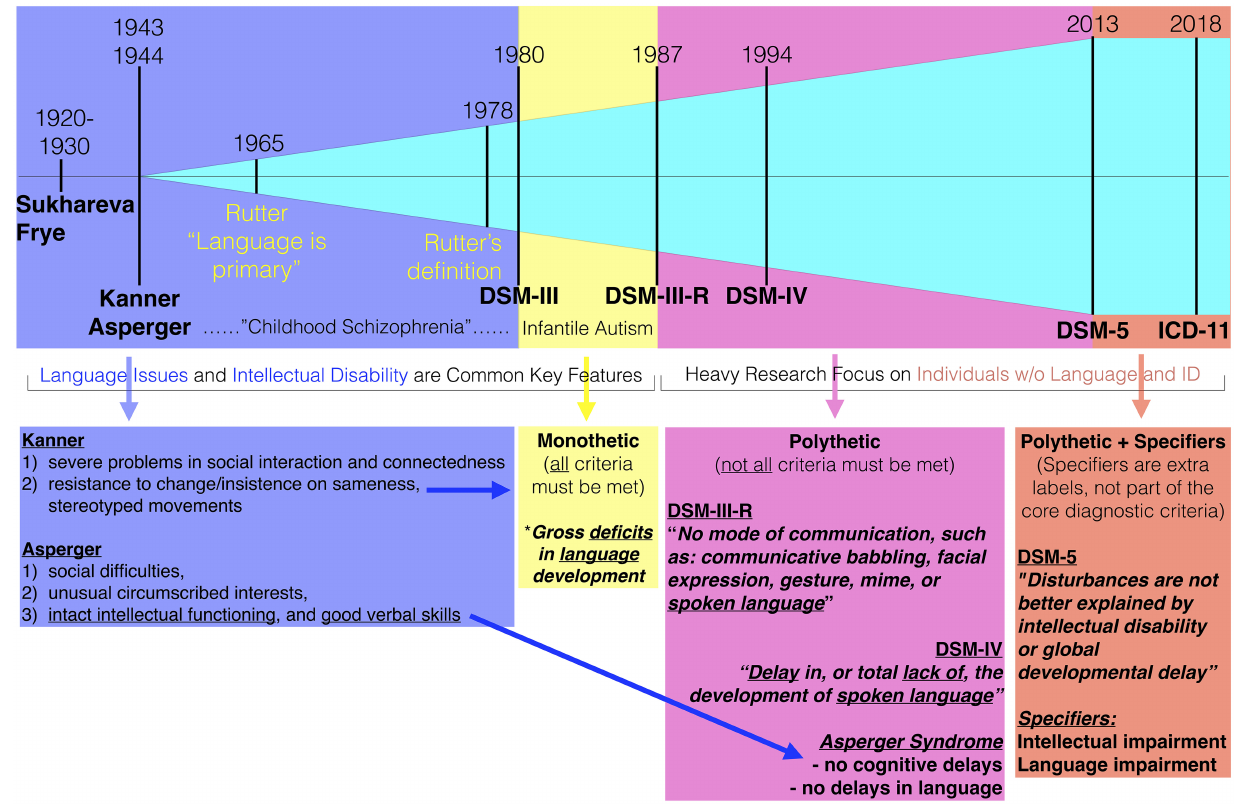
FIGURE 1 | Highlighting the 1987 breakpoint of the change to DSM-III-R criteria. Before DSM-III-R, intellectual disability and early language issues were common key features. Even Rutter’s early opinions were that language was primary or core to autism. The change from monothetic to polythetic criteria in DSM-III-R changed all of this, since it allowed for individuals to be diagnosed without those kinds of issues. Over time, features such as intellectual disability and early language issues were filtered out altogether in the DSM-5 diagnostic criteria and are now used as specifiers. Star indicates one of the monothetic criteria regarding